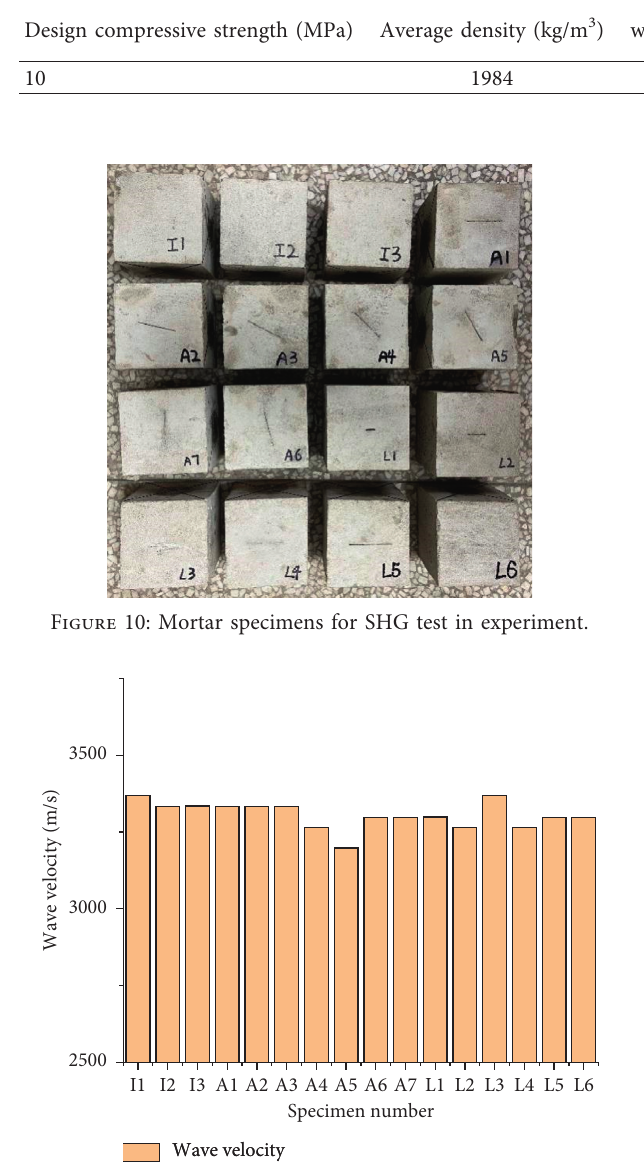
Figure 11: Distribution of wave velocity in each specimen.